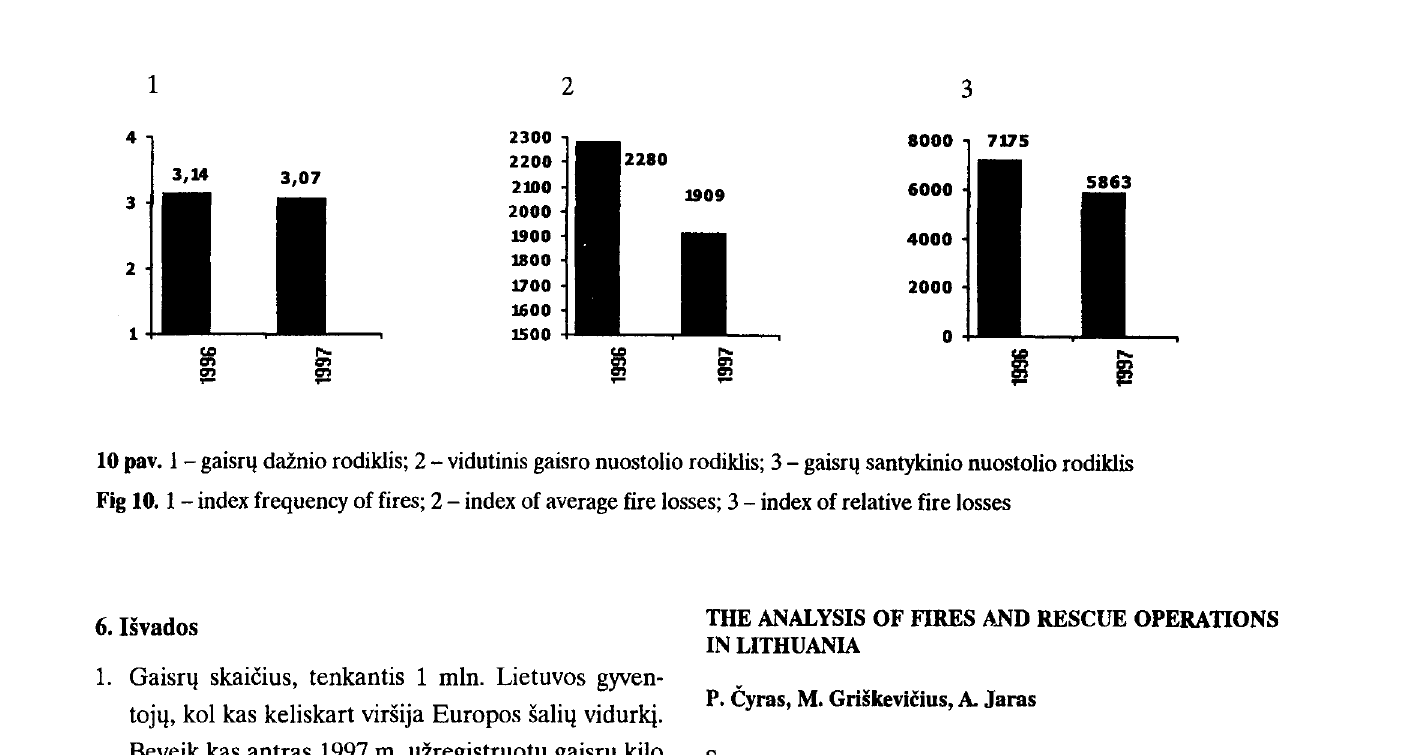
Fig 10. 1 -index frequency of fires; 2- index of average fire losses; 3- index of relative fire